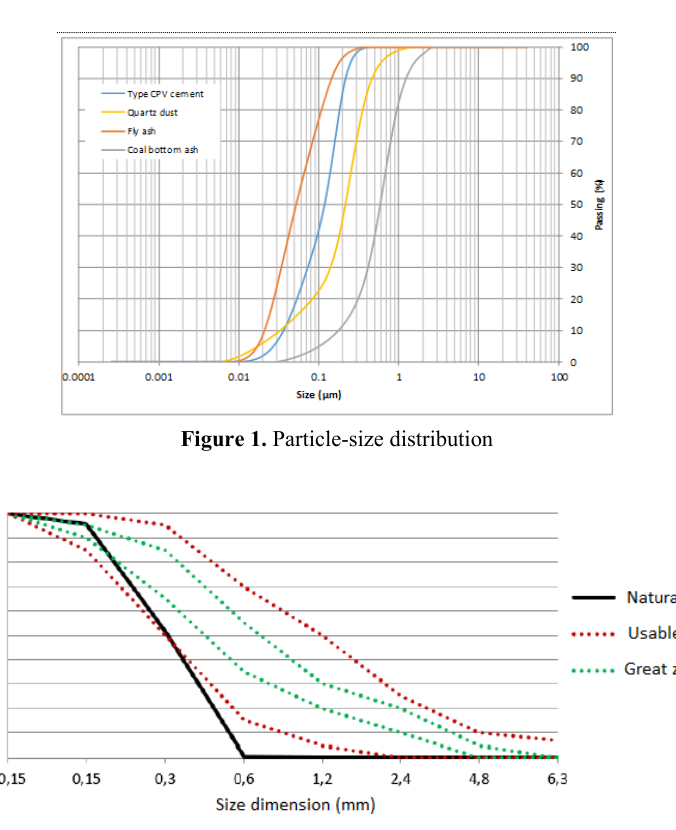
Figure 2. Sand Particle-size